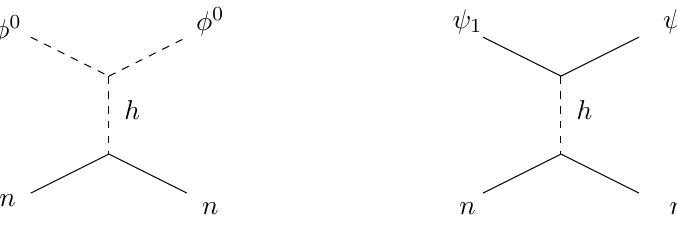
Figure 32. Feynman diagrams for spin independent DM-neucleon scattering process for scalar and fermion